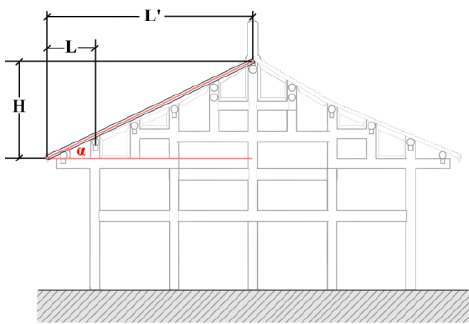
Figure 2. Architectural elements.